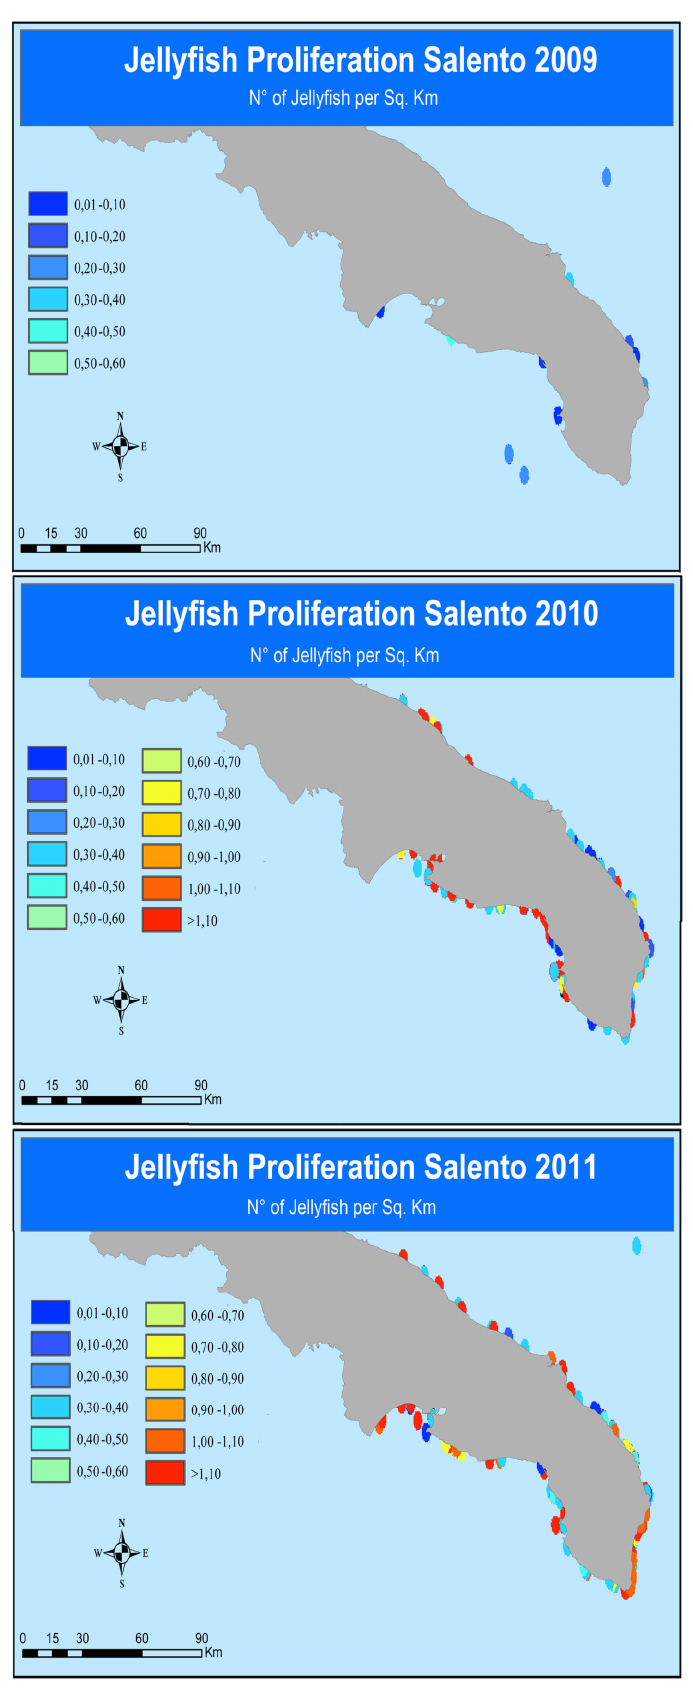
Figure 2. Jellyfish occurrence along the Salento coastline